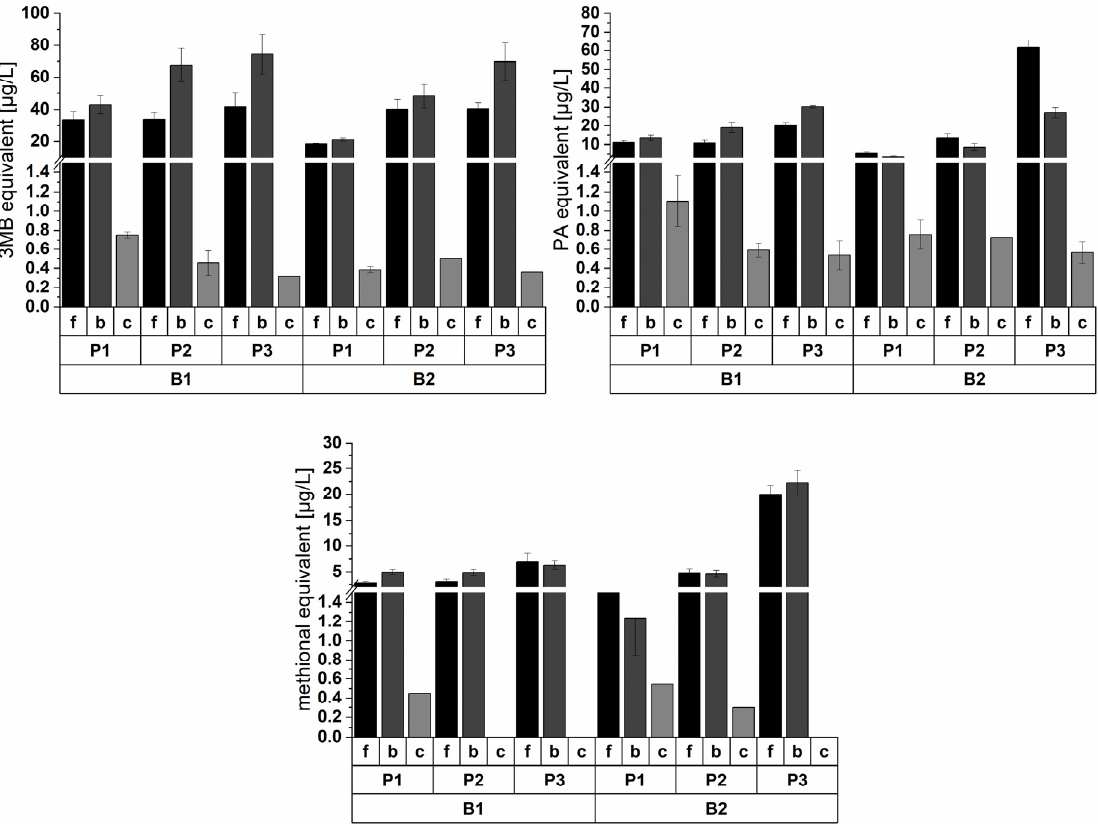
Figure 4. Concentration equivalent of free (f), 4-VP-releasable (b), and cysteinylated (c) forms of 3MB, PA, and methional at the end of boiling ( n =